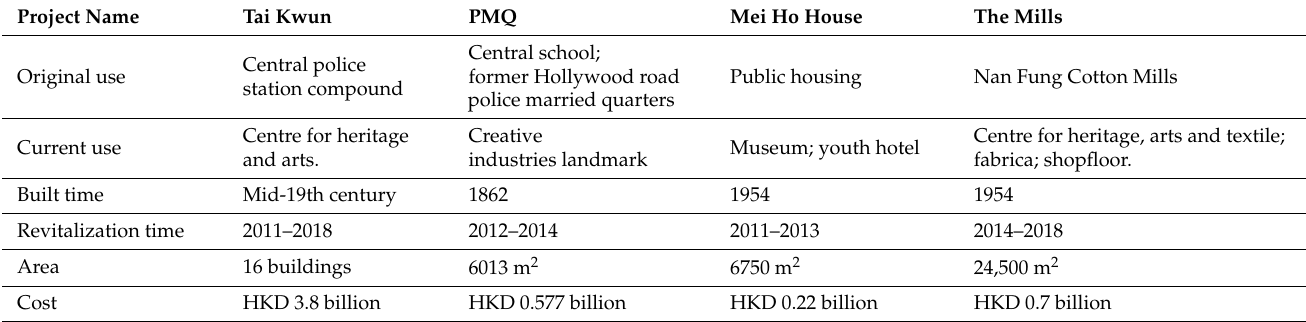
Table 3. The basic data information of Hong Kong heritage revitalization